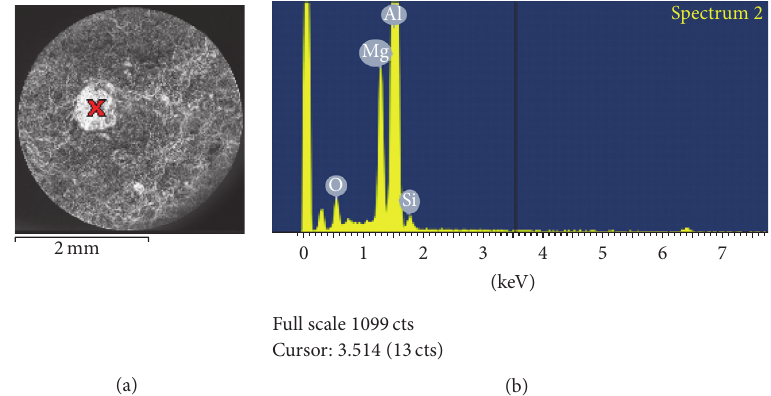
Figure 7: (a) An SEM image of the fracture surface of a specimen from Experiment 2; (b) EDX analysis at the location marked “X” in (a).